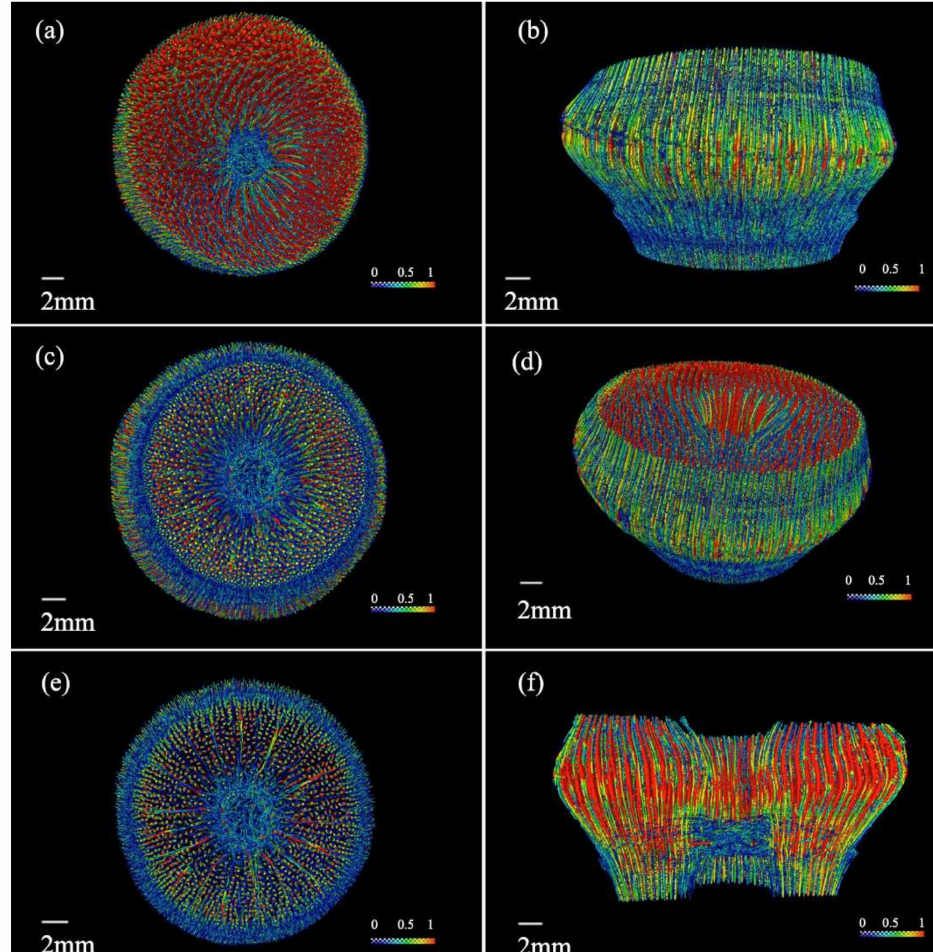
Figure 10. Three-dimensional skeleton of the fibers of the bamboo node (red indicates that the distance from the central axis of the fibers to the nearest boundary was relatively large, and blue indicates that the distance was relatively small). ( a ) Top view. ( b ) Side view. ( c ) Bottom view. ( d ) 3D skeleton. ( e )View of the transverse section. ( f ) View of the longitudinal